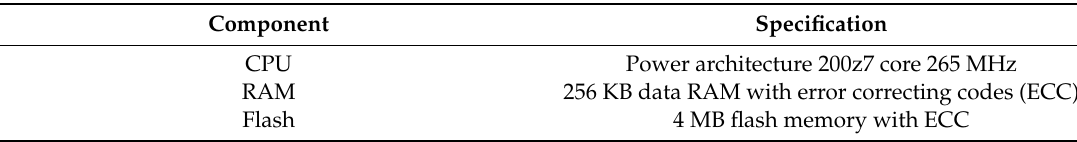
Table 8. Specifications of the central processing unit (CPU), random access memory (RAM), and flash memory of MPC5674F.